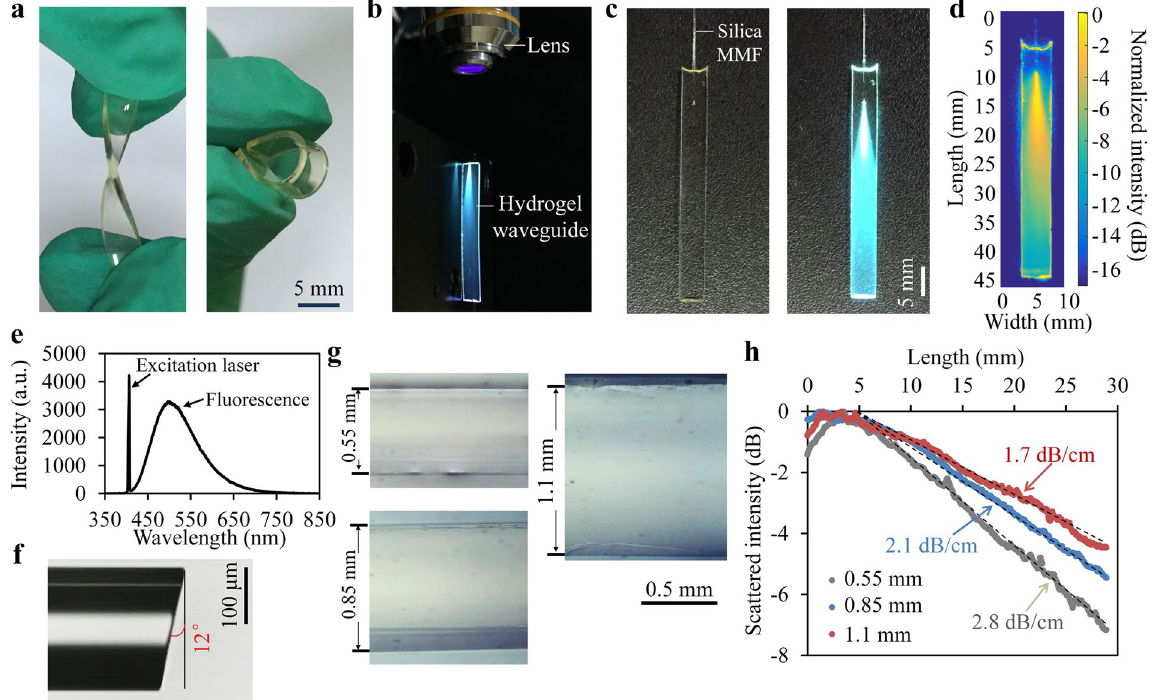
Figure 2. ( a ) Photos of fabricated hydrogel waveguides. ( b ) Light guidance in air. Excitation laser at 405 nm was coupled to a waveguide through an object lens (NA = 0.25). ( c ) Light coupling through a pigtailed silica multimode fiber (MMF). Left, laser off; right, laser on; ( d ) Intensity profile of the scattered light. ( e ) Spectrum of the side-scattered light. ( f ) The coupled silica fiber end cleaved at 12° to suppress the back reflection. ( g ) Optical microscope images showing waveguides thickness at 0.55 mm, 0.85 mm, and 1.1 mm. ( h ) Light guiding losses measured from side-scattered light profiles of the